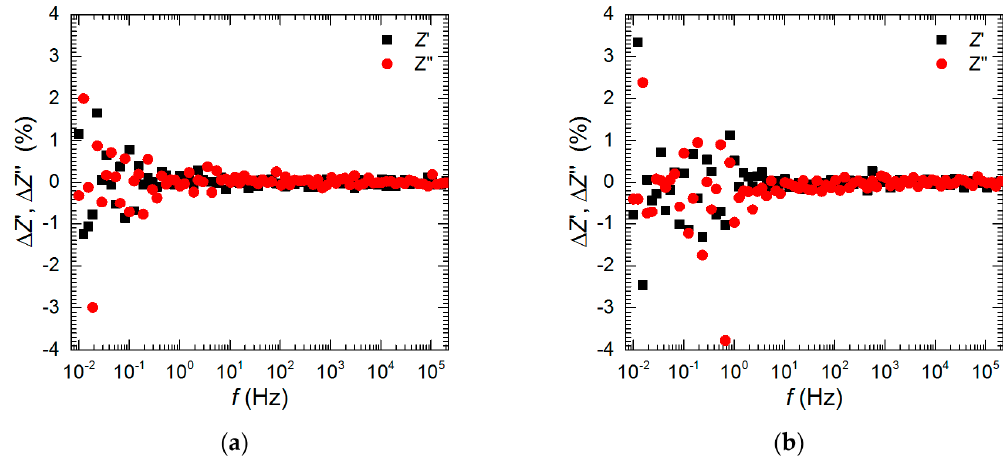
Figure 1. Residual graphs for Kramers–Kronig transformations performed using KK Test software: ( a ) c V = 50 mM, ( b ) c V = 100 mM, pH = 1.3, t = 576 min, T = 303 K.